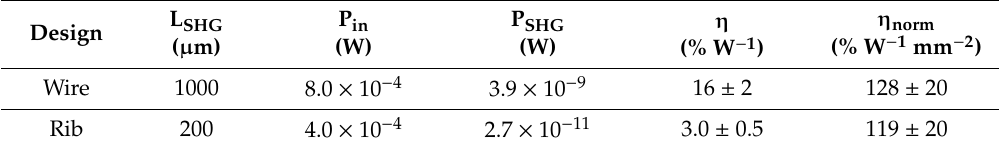
Figure 4. Nonlinear second-harmonic generation (SHG) efficiency spectra for the nanowire (black) and nanorib (red) waveguides. Table 2. Measured nonlinear optical